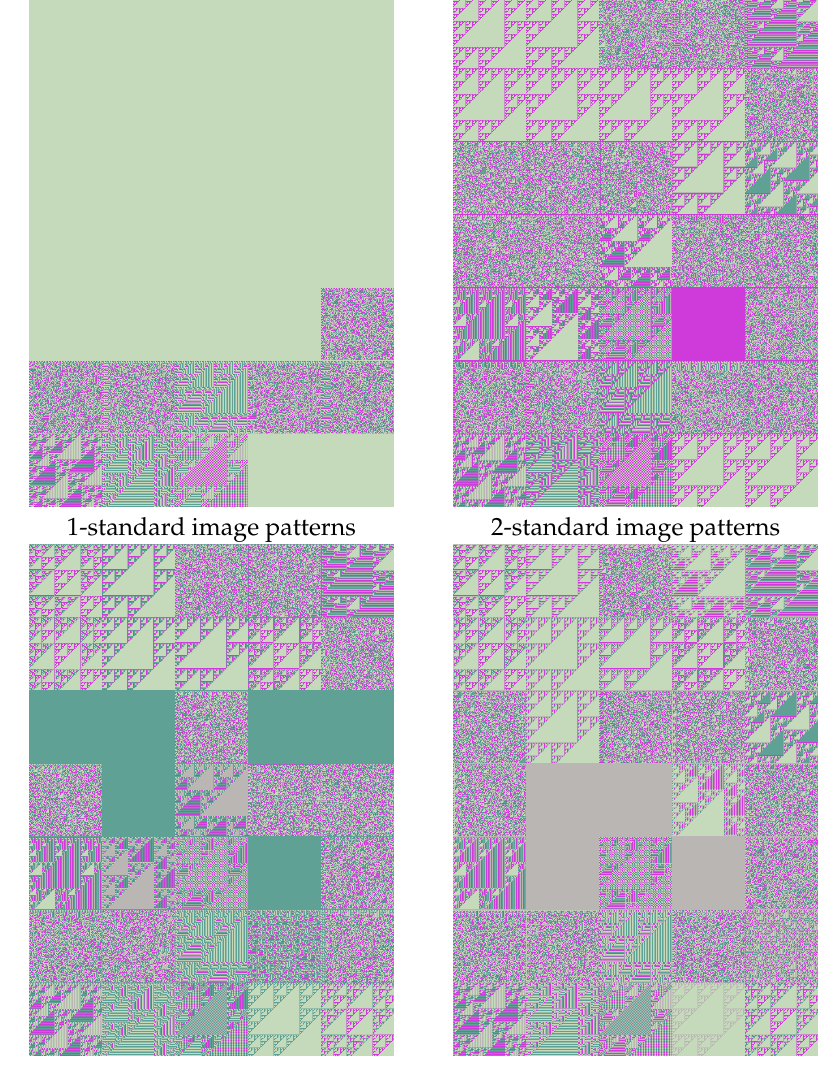
Figure 2. Standard 90 × 90 image patterns associated to the 35 representatives of isomorphism classes of Latin squares of order four described in Figure